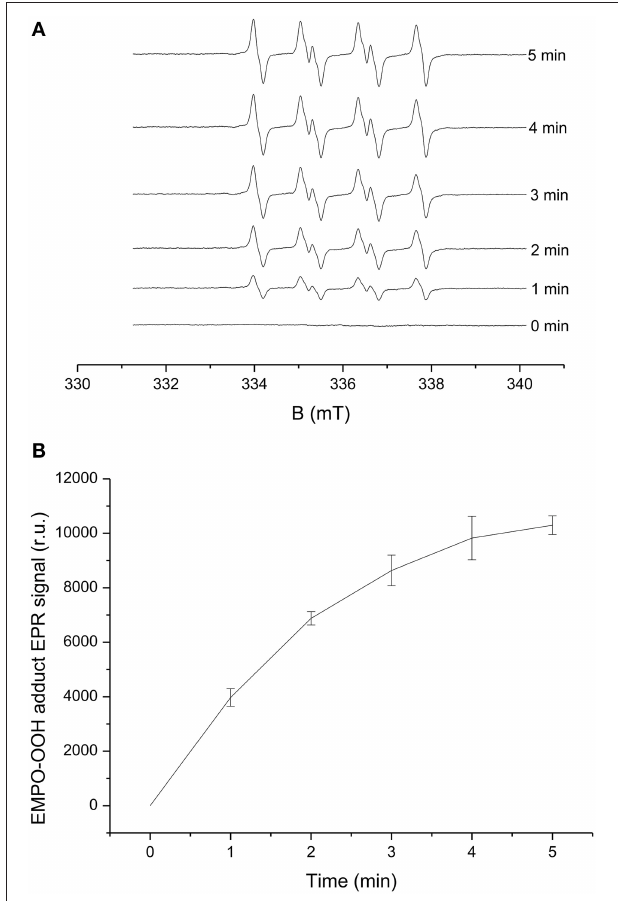
FIGURE 1 | Light-induced EMPO-OOH adduct EPR spectra measured in PSII membranes. EMPO-OOH adduct EPR spectra were measured